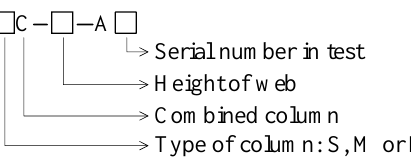
Figure 3. Naming rules of the combined column.